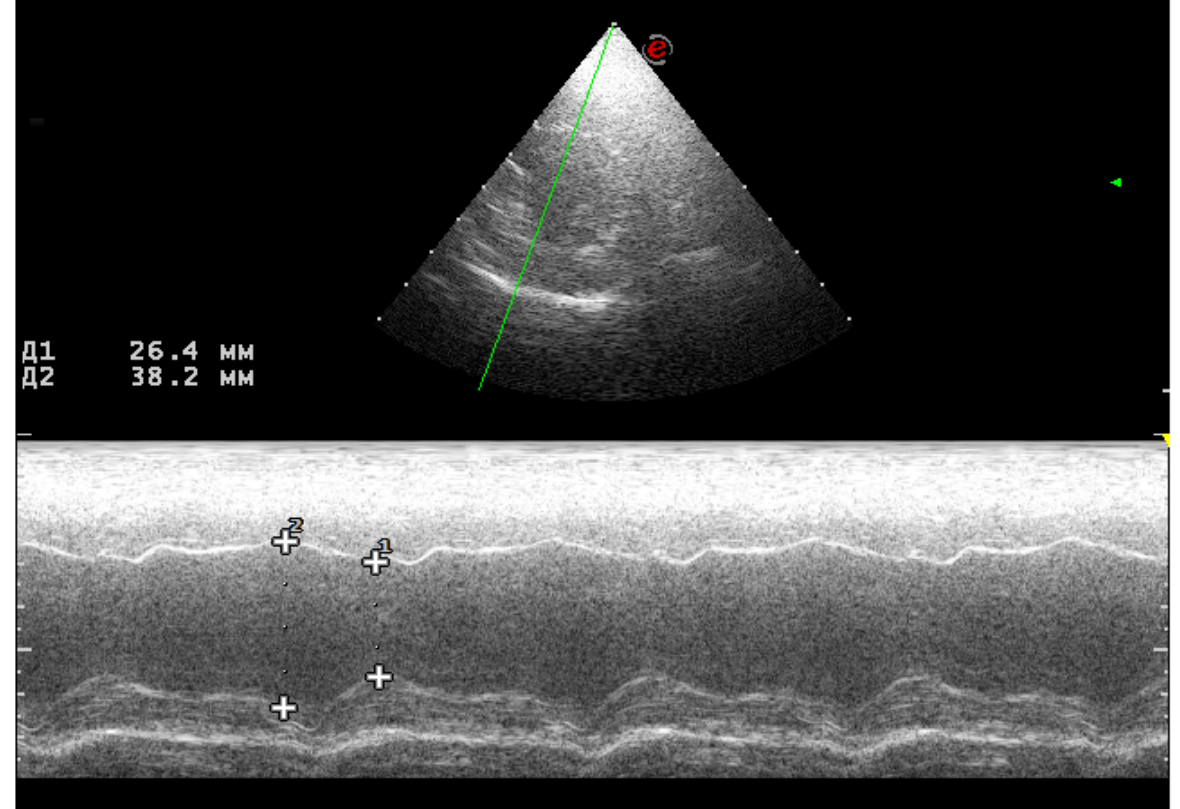
Fig. 2. Ultrasonogram of the dog's heart before therapy, M-mode. R1 is the final systolic size, and R2 is the final diastolic size. FS-32 %, PV-60 %